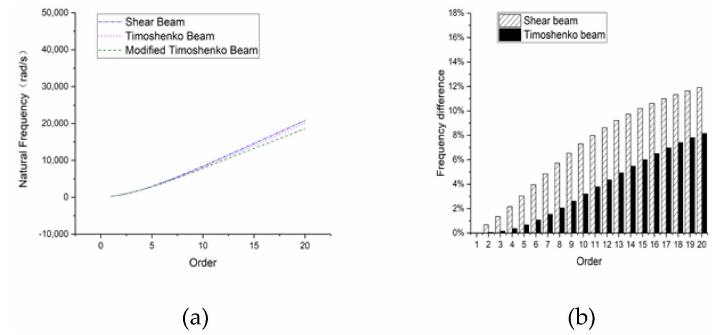
Figure 7. Natural frequencies of the 8-m-long beam: ( a ) overall frequency curve and ( b ) frequency di ff erence compared with a modified Timoshenko beam.